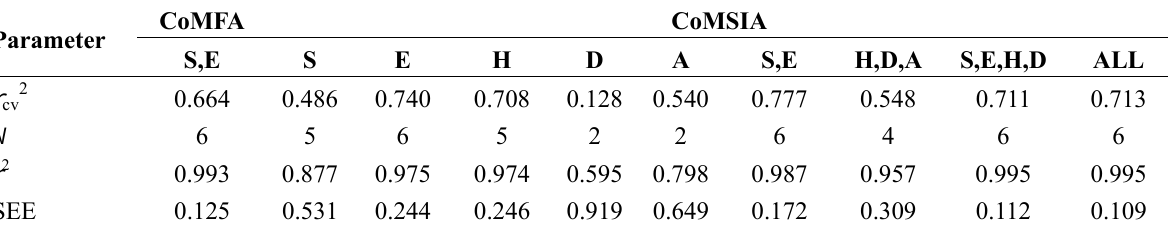
Table 4. Results of CoMFA and CoMSIA analyses with docking-based